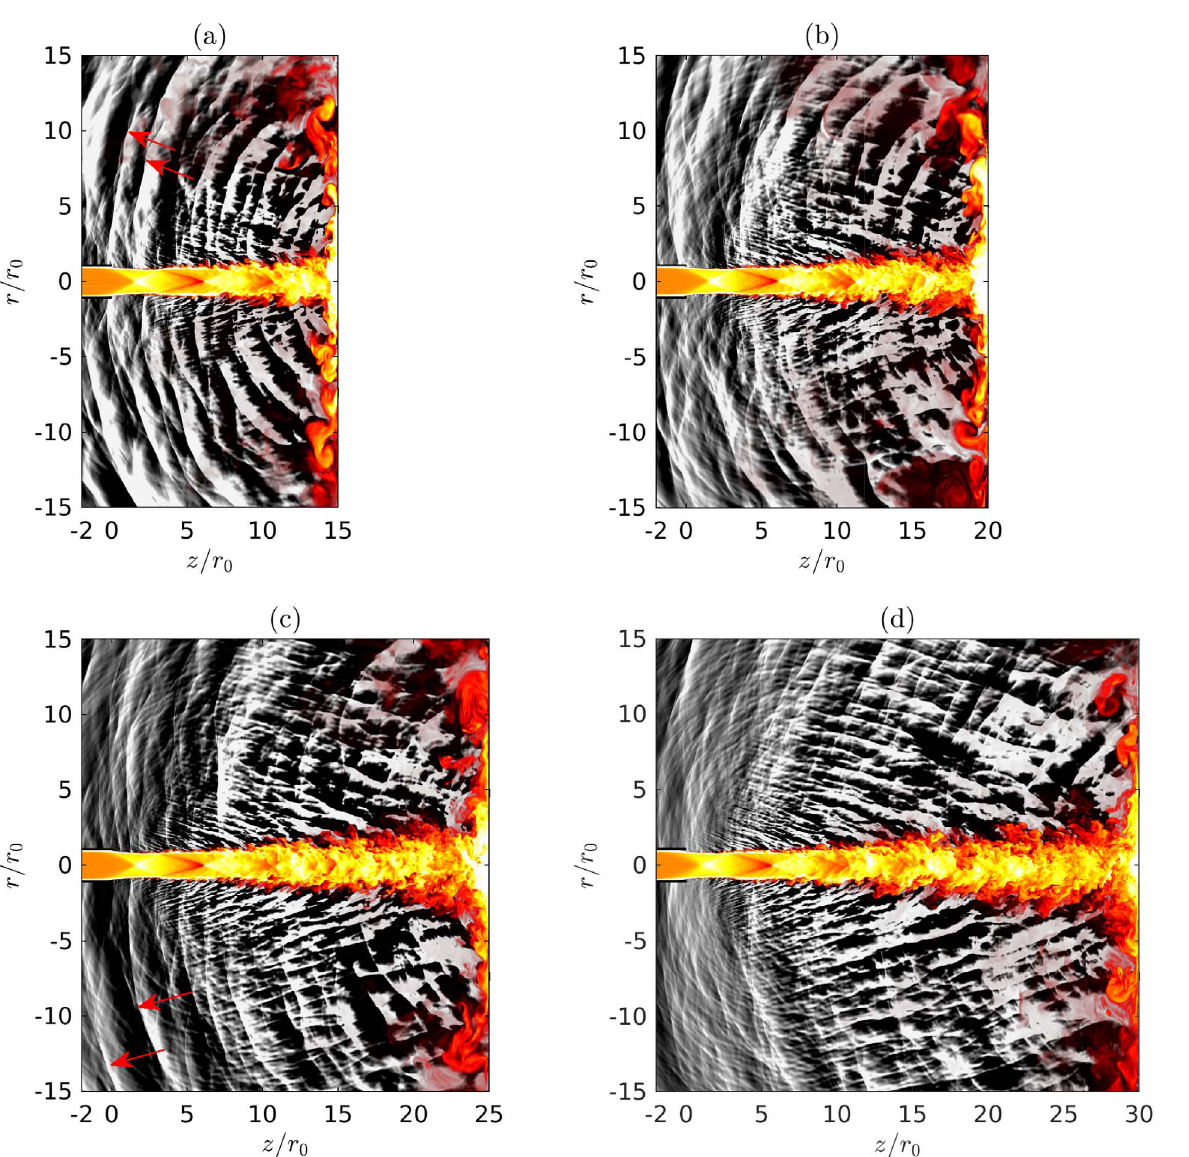
Figure 4. Snapshots in the ( z , r ) plane of temperature fl uctuations in the fl ow and of pressure fl uctuations outside for (a) L = 15 r 0 , (b) L = 20 r 0 , (c) L = 25 r 0 and (d) L = 30 r 0 . The red arrows show the wavefronts of two consecutive upstream-propagating pressure waves for the nozzle-to-plate distances L = 15 r 0 and 25 r 0 . The color scales range from 0 to 780K for temperature, from red to white, and from (cid:4) 2000 to 2000 Pa for pressure, from black to